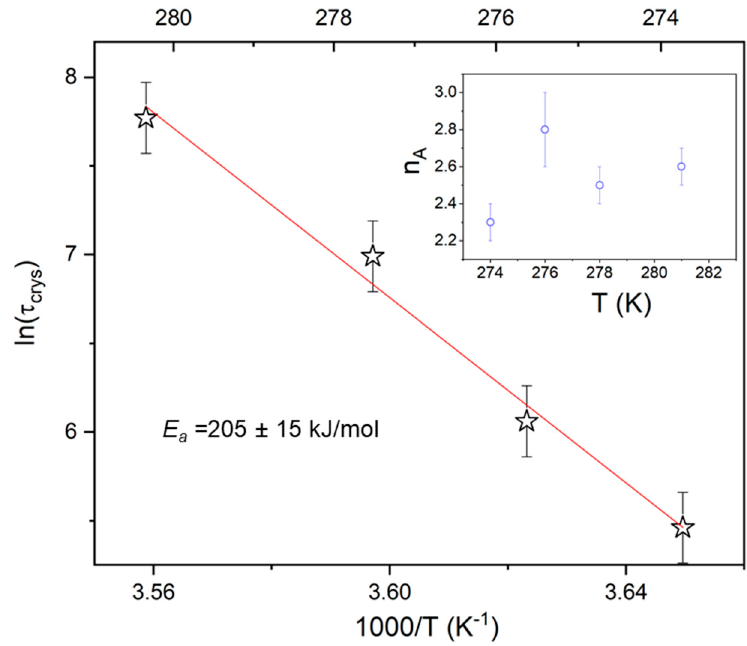
Figure 8. Temperature dependence of the characteristic crystallization time ( τ cryt ) for the isothermal melt crystallization form (SmB cryt ) of BBOA. The inset presents the Avrami exponent n A versus temperature. Table 2. Parameters of isothermal melt crystallization kinetics of BBOA estimated by the Avrami model at different temperatures.